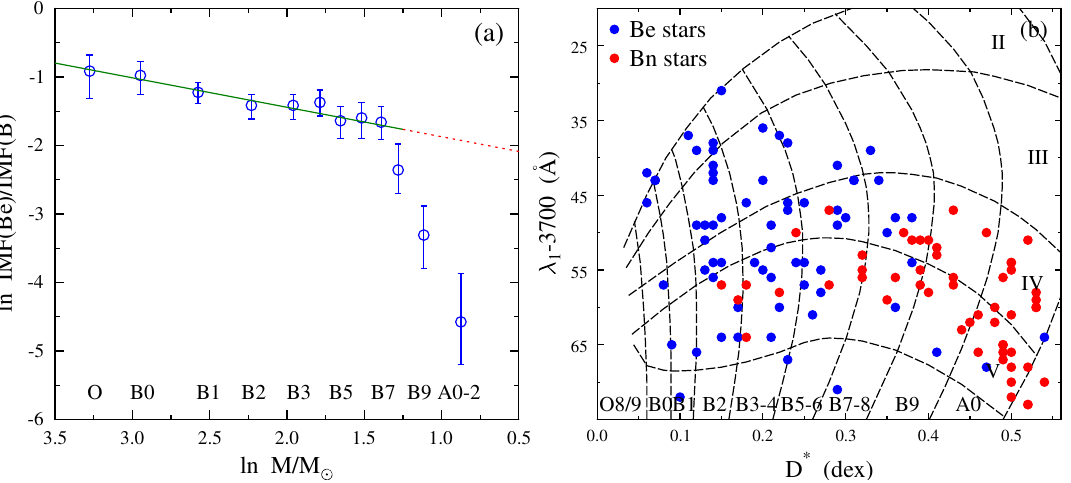
Figure 11. ( a ) Fraction of Be stars compared to the entire number of B-type stars; adapted from Zorec and Briot [18]; and ( b ) BCD parameters of Be and Bn stars; adapted from Cochetti et al. [146]. Among the reasons that may explain the lack of Be stars with spectral types cooler than B7 is that, for effective temperatures, T eff (cid:46) 12,500 K, the average CD temperature in the effective emitting volume, drops to T CD ∼ 0.6 T eff (cid:46) 9000 K [109], so that hydrogen